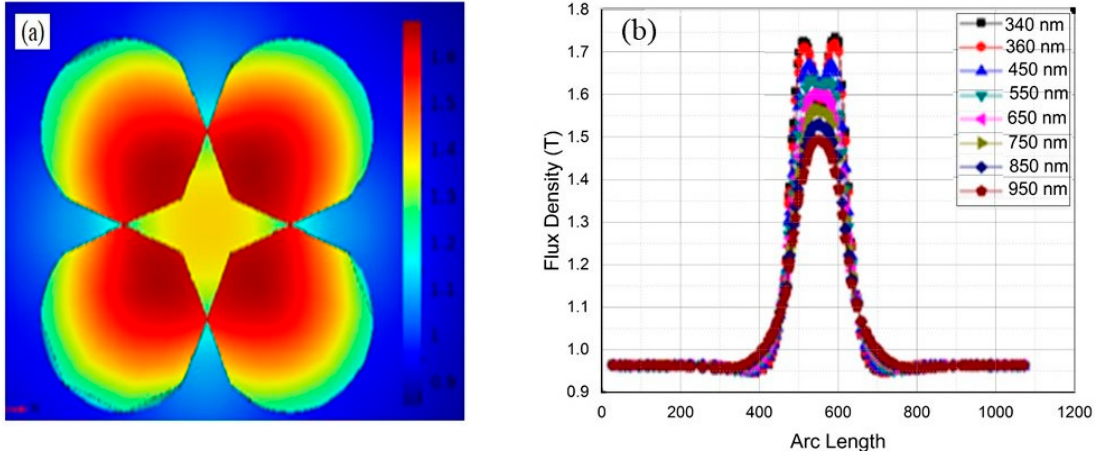
Figure 6. ( a ) The coupled plasmons formed by incidence of light on four GaN nanowires. The color legend shows the flux density at different positions. ( b ) The changes in flux density across geometry where plasmons are formed and propagate at different wavelengths from 340 nm to 950 nm when four GaN nanowires are placed together to study the coupling effects.